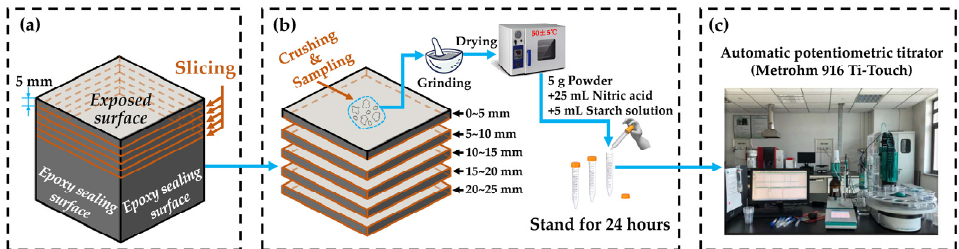
Figure 4. The measurement of chloride ions’ content at different depths. ( a ) Specimen slicing, ( b ) assay preparation, and ( c ) chloride ions’ content measurement.